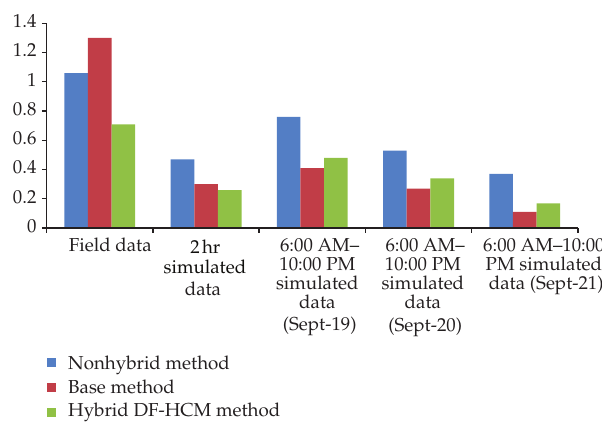
Figure 7: Performance of models in terms of RMSE for field and simulated